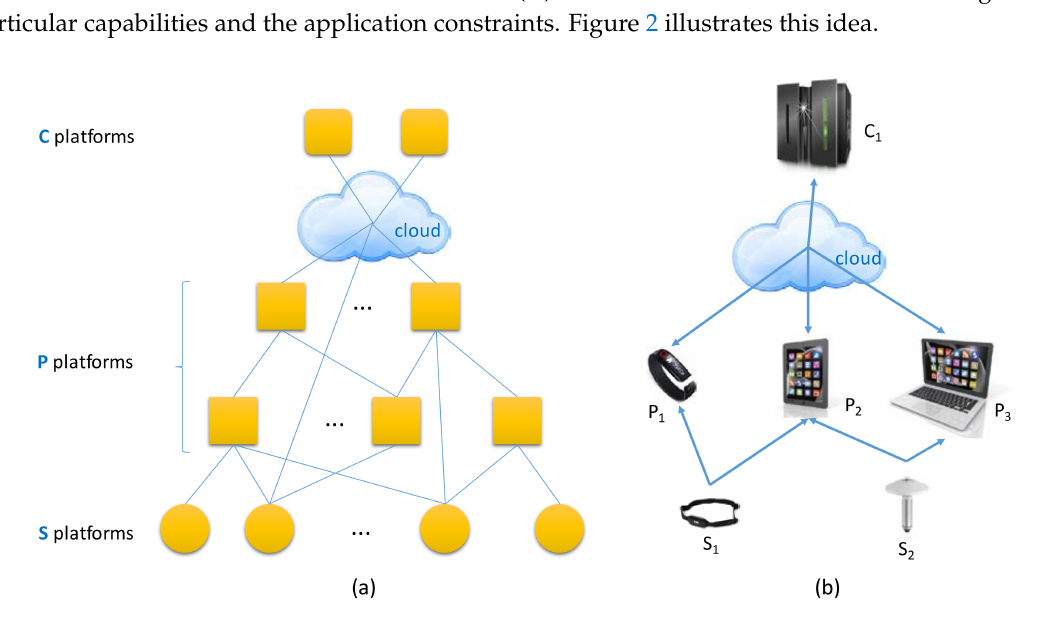
Figure 1. Diagram of different flow possibilities in our proposed distributed system.